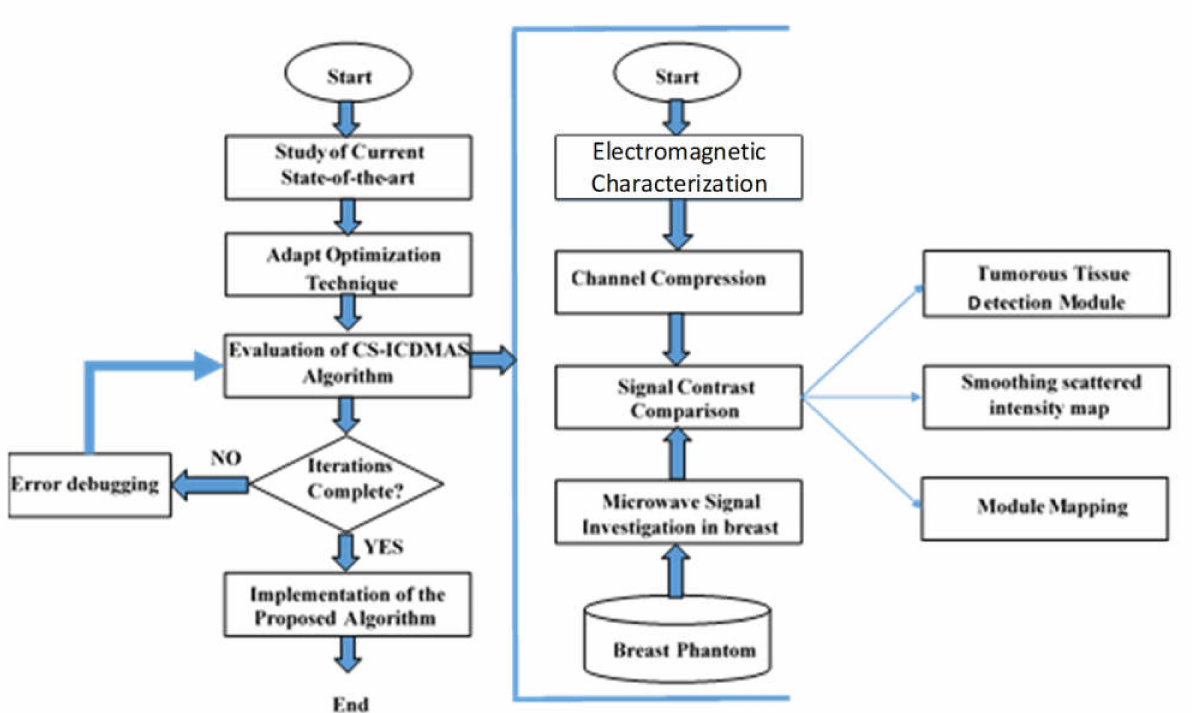
Figure 1. Flowchart of the research methodology.